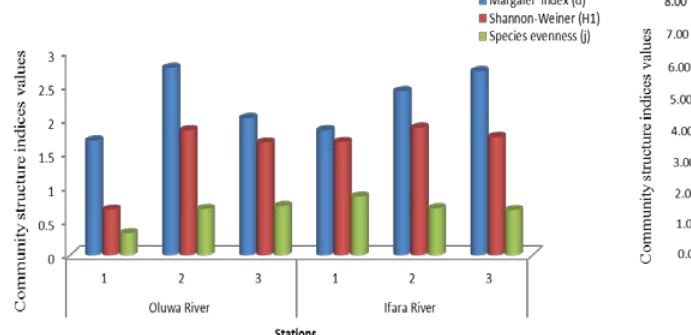
Fig. 2. Comparison of microalgal community structure indices at Ibefun River, Ogun